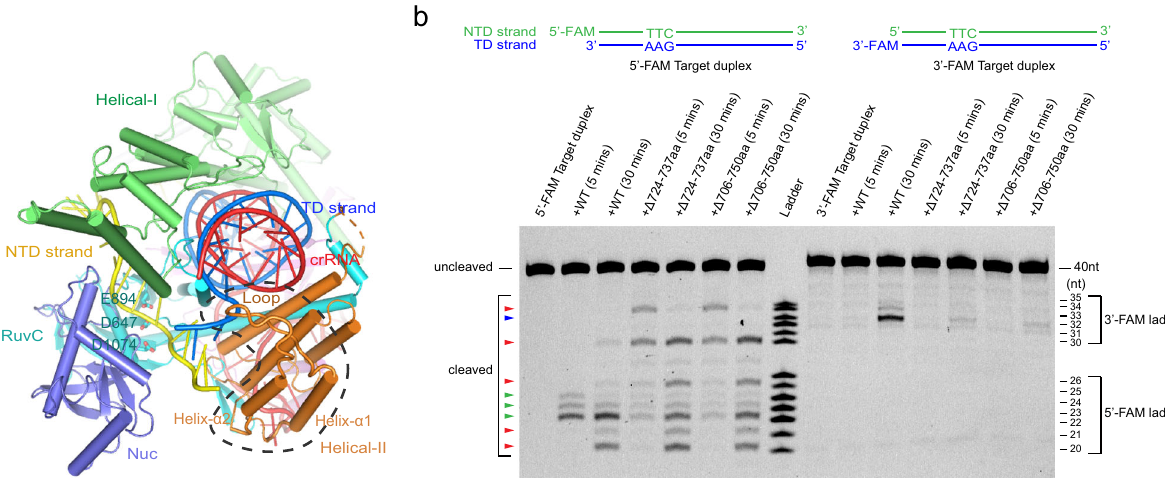
Fig. 5 A loop region in the Helical-II domain facilitating the TD strand loading. a A loop region (residues 724 – 737aa) and the region comprising this loop and two connected helices (residues 706 – 750aa) in the Cas12i1 R-loop ternary complex are encircled with a black dashed line. b Denaturing gel demonstrating the cleavage of the fl uorescently 5 ′ -FAM-NTD strand-labeled or 3 ′ -FAM-TD strand-labeled DNA substrate by wild-type Cas12i1, △ 724 – 737aa, and △ 706 – 750aa mutants in complex with crRNA. The cis -cleavages of the NTD and TD strands are labeled with the green and blue triangles, respectively, and the trans -cleavages are labeled with the red triangles. The cleavage assays were repeated three times independently to con fi rm the repeatability and source data are provided as a Source data fi